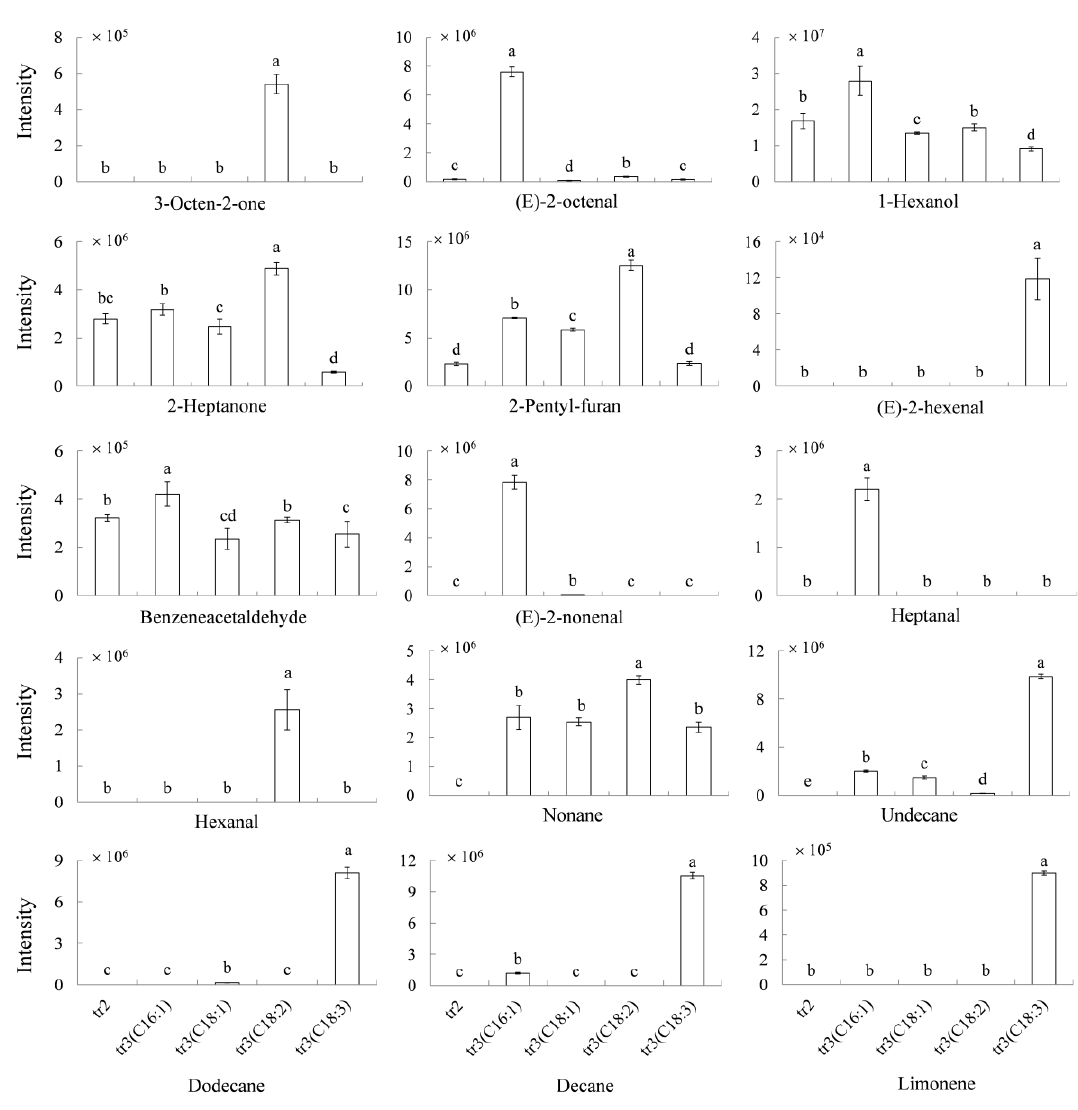
Figure 4. Model experiment to explain the generation of the volatiles from palmitoleic acid, oleic acid, linoleic acid, and linolenic acid. tr2 and tr3 represented treatment 2 and treatment 3, respectively. C16:1, C18:1, C18:2, and C18:3 represented palmitoleic acid, oleic acid, linoleic acid, and linolenic acid, respectively. The significance of the differences (different letters) was determined at p < 0.05. Data were shown as the mean ± SD values (n = 3).